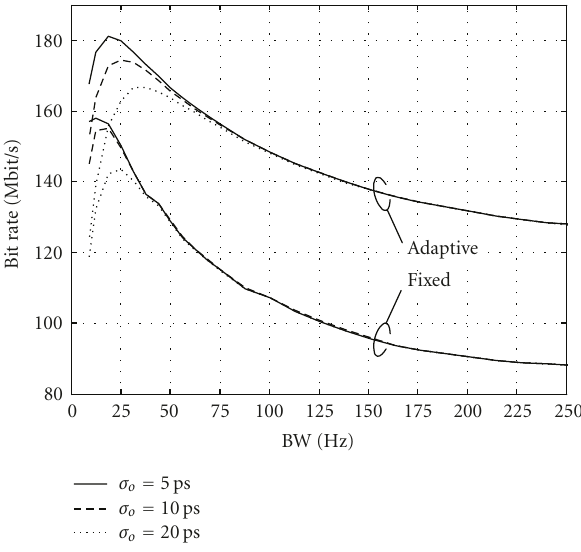
Figure 9: Bit-rates estimated from SNDR values and a lookup table. picts the SDR values obtained when the time-variant channel shown in Figures 1 and 2 is employed but no jitter is intro- duced in the ADC